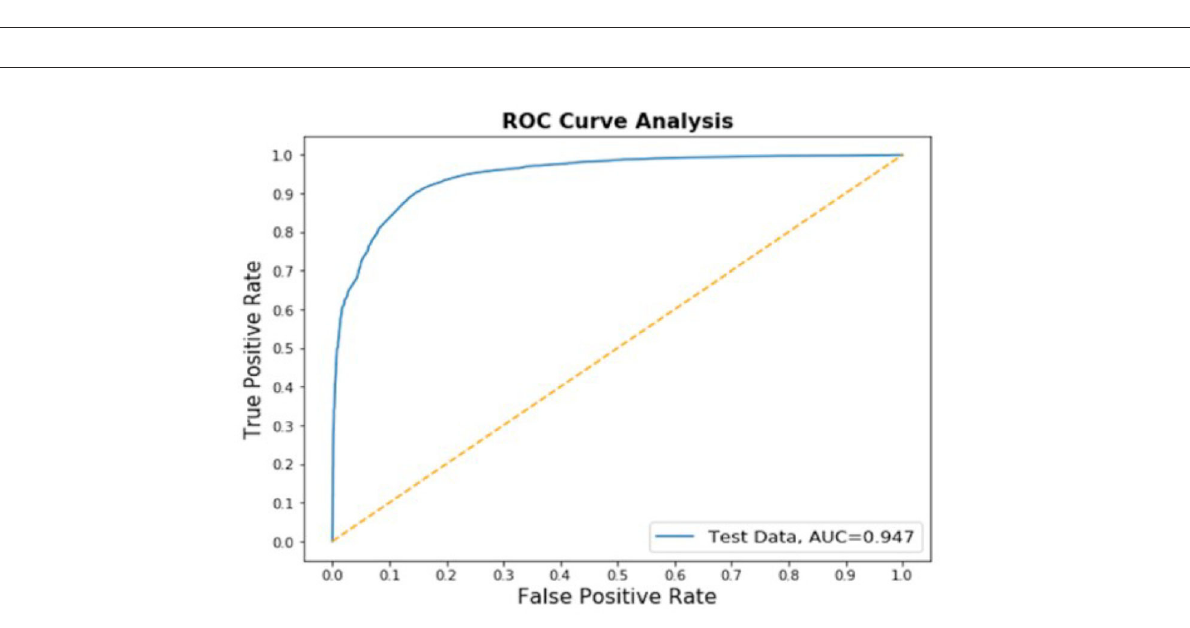
FIGURE5 The ROC of the